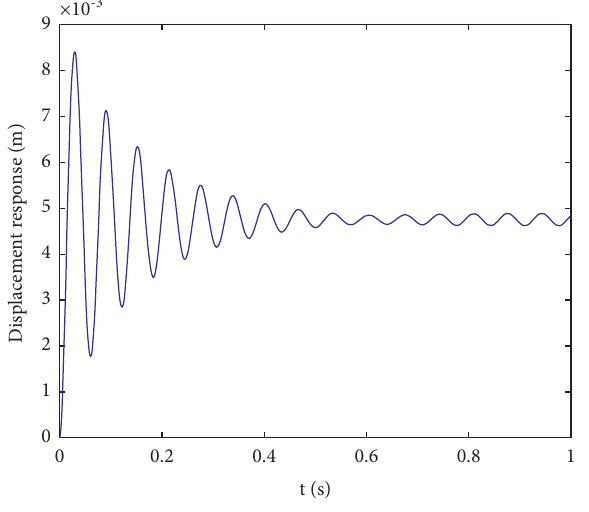
Figure 10: Midpoint response process.